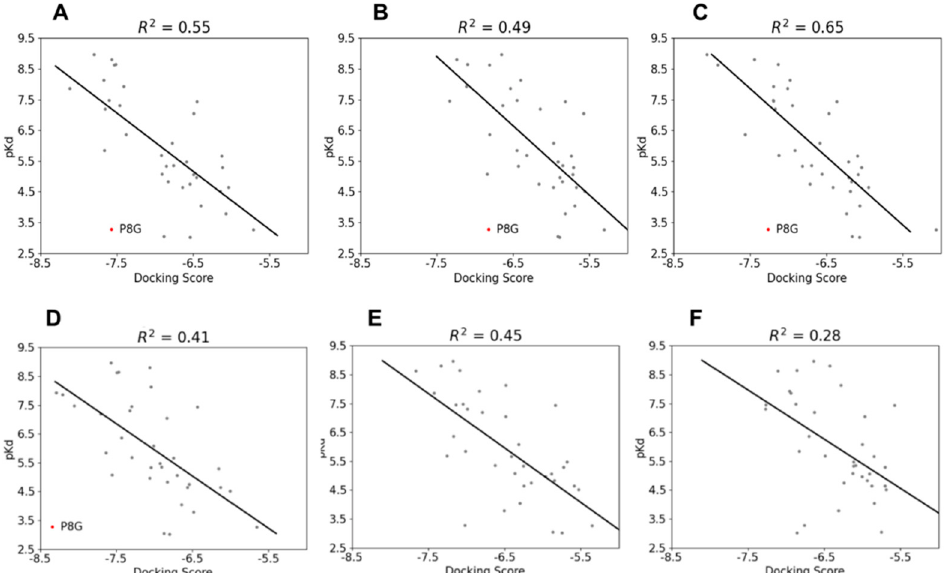
Figure 5. Regression analysis of blind docking results. Linear regression plots of ( A ) 6F2Q_0, ( B ) 6F2Q_1, ( C ) 1KJR, ( D ) 5ODY, ( E ) 6EOL and ( F ) 5E89 illustrate the blind docking results. The outliers detected during clustering are highlighted in red and their names are shown in the image.